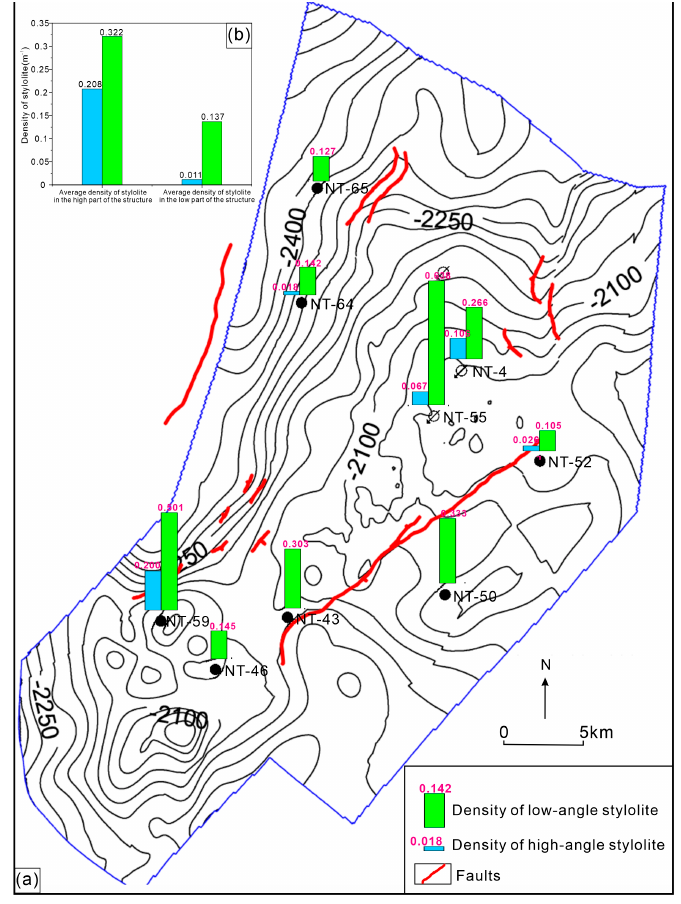
Figure 7. The distribution characteristics of the second ‐ stage stylolites in the NT oilfield. ( a ) The planar distribution of the second ‐ stage stylolites in the NT oilfield. ( b ) Comparison of the stylolites density in the high part and in the low part of the anticline.